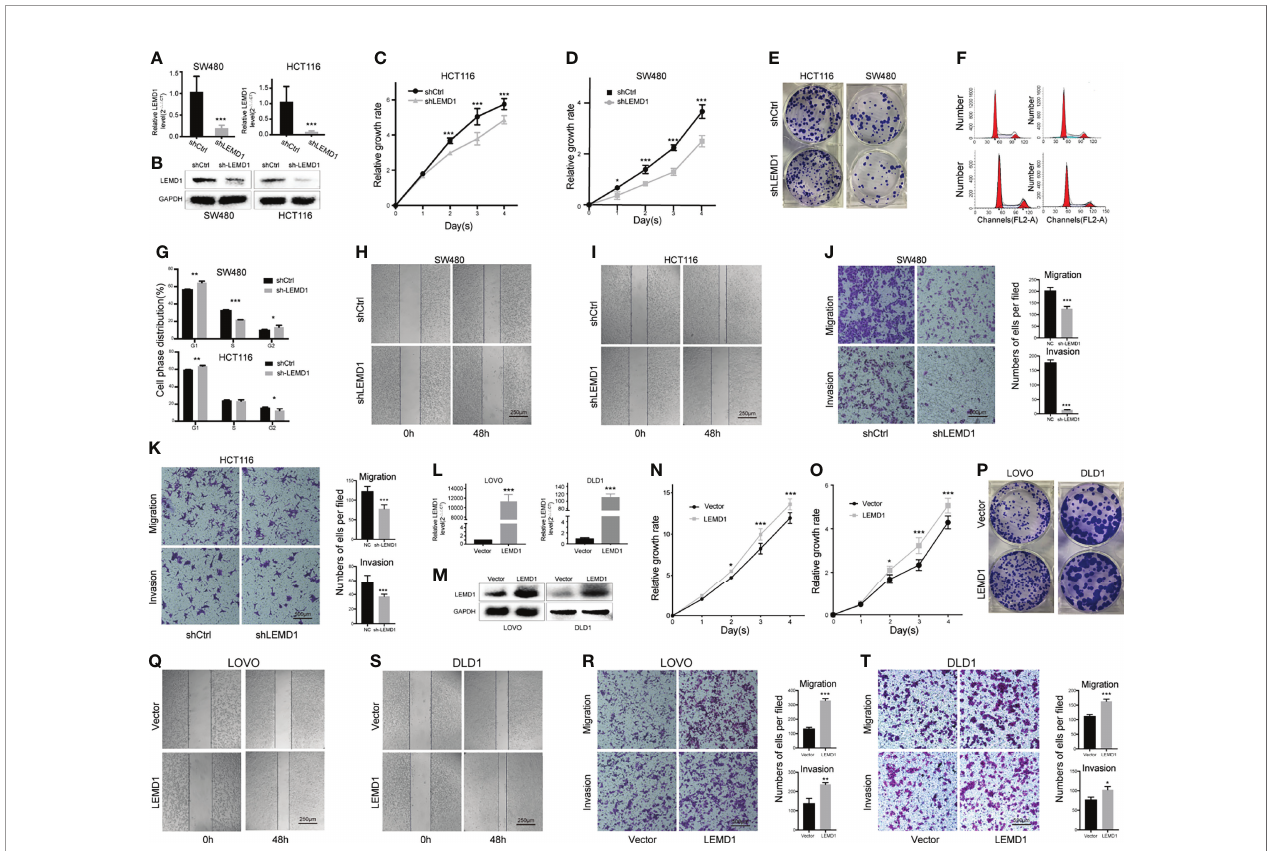
FIGURE 6 | Effects of LEMD1 on the biological behavior of CRC cells. (A, B) LEMD1 knockdown in SW480 and HCT116 was con fi rmed by qRT-PCR (A) and western blotting (B) ; LEMD1 knockdown suppressed SW480 (C) and HCT116 (D) proliferation determined by the CCK8 assay and clone formation assay (E) ; (F, G) Cell cycle changes after knockdown LEMD1; (H, I) LEMD1 knockdown inhibited cell migration by the wound healing test; (J, K) LEMD1 knockdown inhibited invasion and migration of SW480 (J) and HCT116 (K) cells by the Transwell assay; (L, M) LEMD1 overexpression in LOVO and DLD1 was con fi rmed by qRT-PCR (L) and western blotting (M) ; LEMD1 promoted proliferation of LOVO (N) and DLD1 (O) as determined by CCK8 assay and clone formation assay (P) ; Overexpression LEMD1 promoted cell migration by the wound healing test (Q, S) ; Overexpression LEMD1 promoted LOVO (R) and DLD1 (T) cell invasion and migration by the Transwell assay. *p < 0.05; **p < 0.01; ***p <